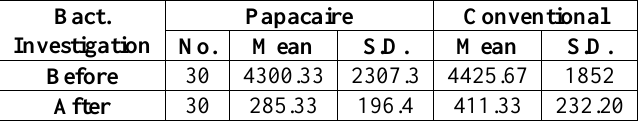
Table 2: Summary statistics of